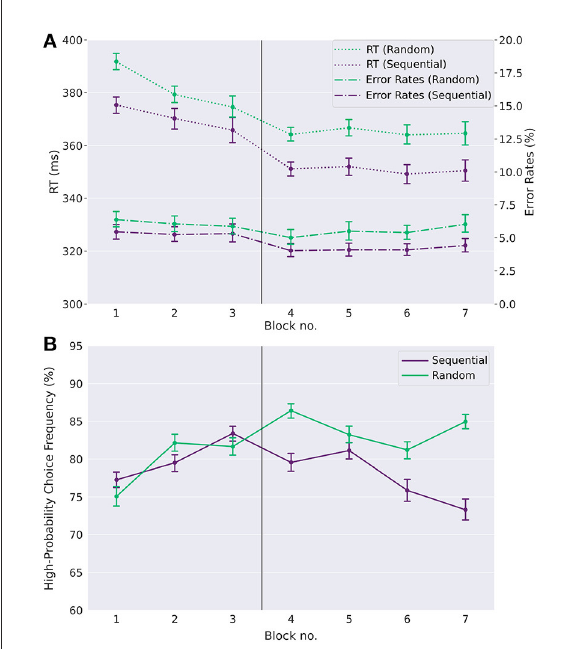
FIGURE2 Learning of automatic action sequence and goal-directed task. (A) Reaction times (RT) and error rates (ER) (timeouts and wrong responses) in the random and the sequential condition across single-target trials. Participants show faster reaction times and lower error rates in the sequential condition than in the random condition, evidenced by a main effect of task condition (see text). This is already the case in the first blocks of day one, suggesting that participants quickly internalized the repeating sequence to a certain degree, exploiting the anticipation of upcoming target positions for fast reaction times. Furthermore, participants’ reaction times decrease over time, as do the error rates, showing a learning effect with time. (B) High reward-probability (H.P.) choice frequencies in choice trials. H.P. choice frequencies remain far above the chance level of 50% in both experimental conditions, showing that participants generally acted in a goal-directed manner. However, while there is no difference between the experimental conditions on day one, a difference emerges on day two. As can be seen, high reward-probability choice frequencies on day two are reduced in the sequential condition compared to the random condition. Error-bars show standard errors of the means. The vertical line between blocks three and four marks the separation between day one and day